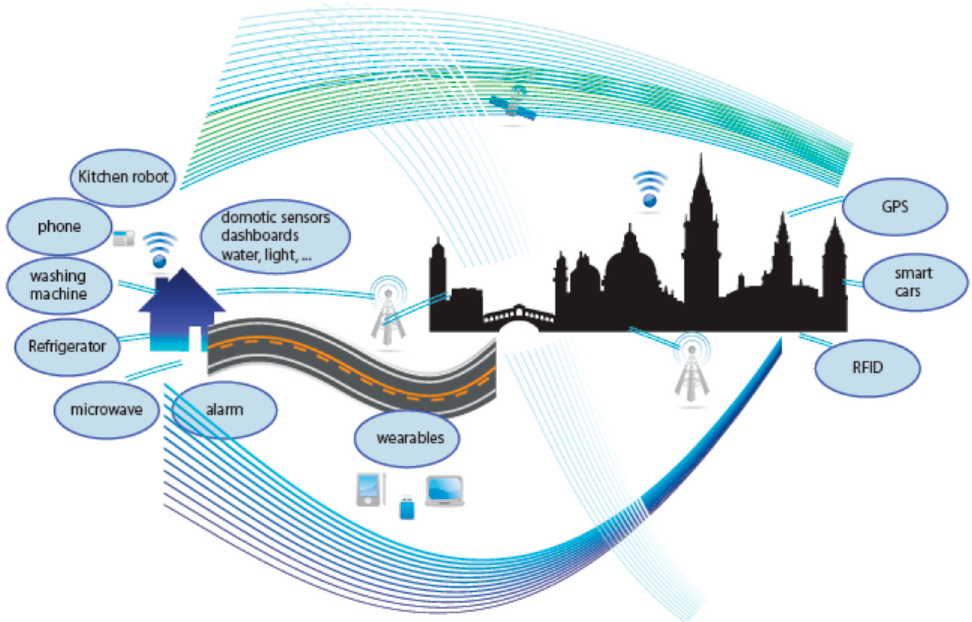
Figure 1. Illustration of data acquisition equipment in IoT.